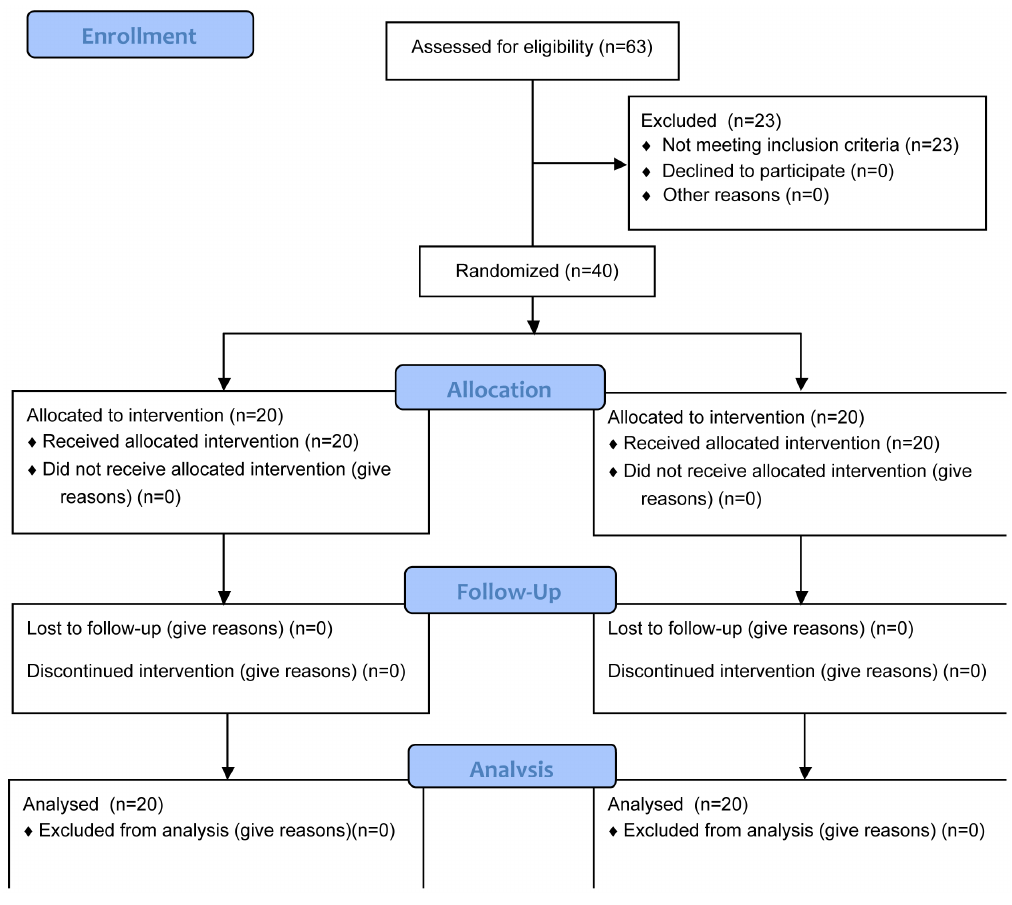
Figure 2. The CONSORT flow diagram for this study.